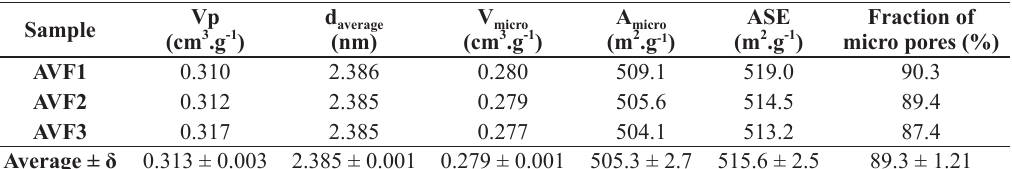
Parameters of the porous structure of AVFs activated under a heating rate of 2.5 °C.min -1